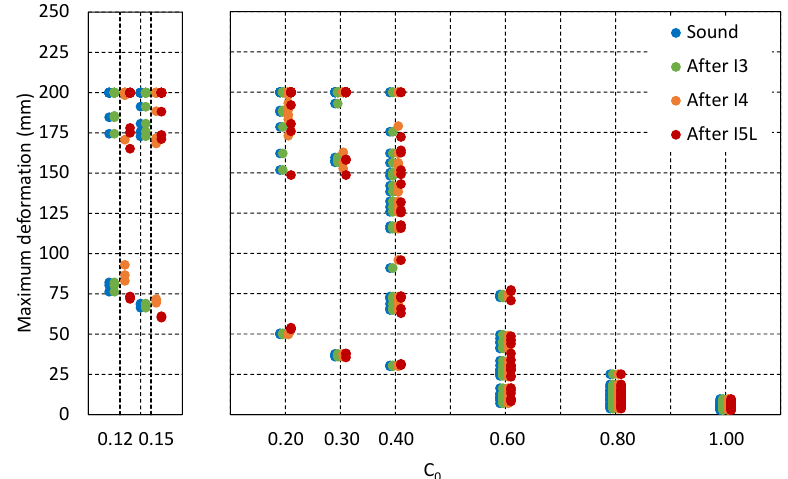
Figure 12. Result of maximum deformation.